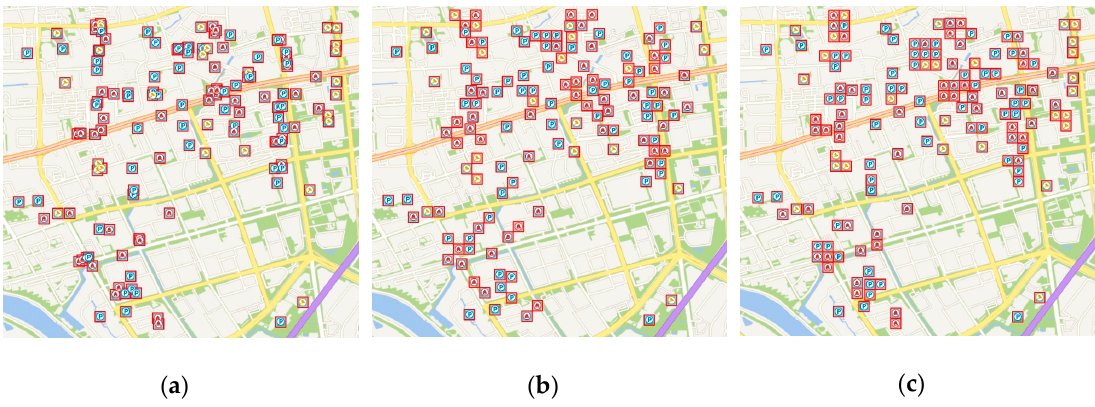
Figure 9. Comparison of points data in Region I: ( a ) original points data, ( b ) point data generalized by the proposed method; ( c ) point data generalized by Yang’s method.